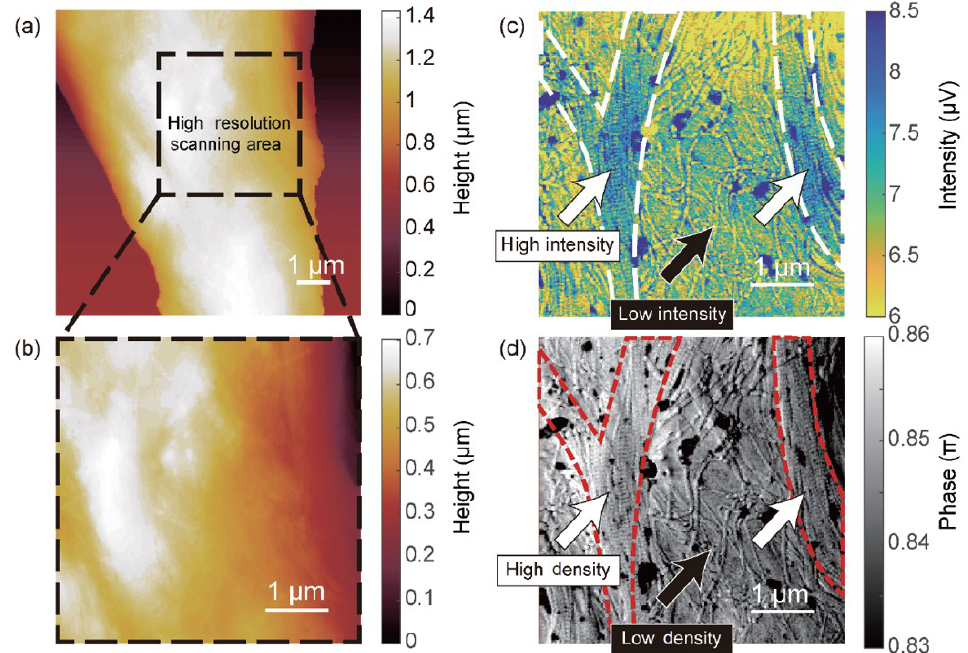
Figure 6. Scattering type SNOM image of collagen fibrils on a nerve section surface: ( a , b ) topography image of a section of the collagen fibrils, ( c ) third harmonic amplitude image at 1100 cm − 1 with labels of the high-density area, ( d ) force phase image of the collagen fibrils (adapted with permission from [91], copyright 2021 Springer